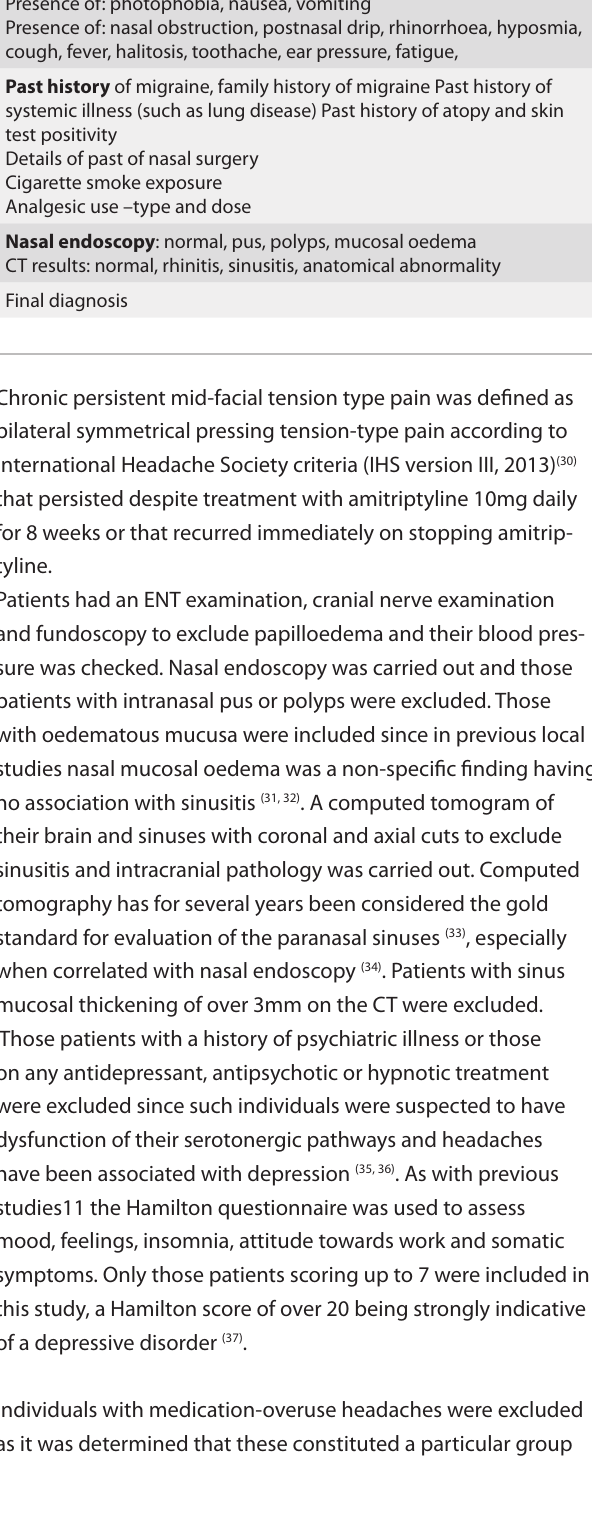
Table 3. Structured Clinical Interview for facial pain patients and their follow-up. Length of history Site : periorbital, paranasal, cheeks, frontal, vertex, occipital, temporal- unilateral, bilateral Quality : pressing, aching, throbbing or other Duration , frequency and intensity Presence of: photophobia, nausea, vomiting Presence of: nasal obstruction, postnasal drip, rhinorrhoea, hyposmia, cough, fever, halitosis, toothache, ear pressure, fatigue,